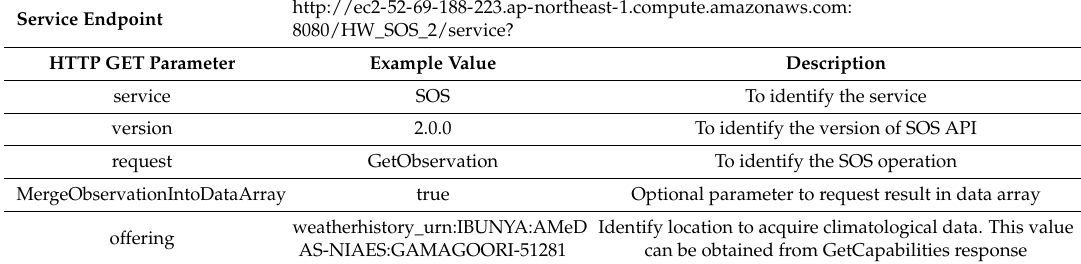
Table 2. HW SOS and GetObservation